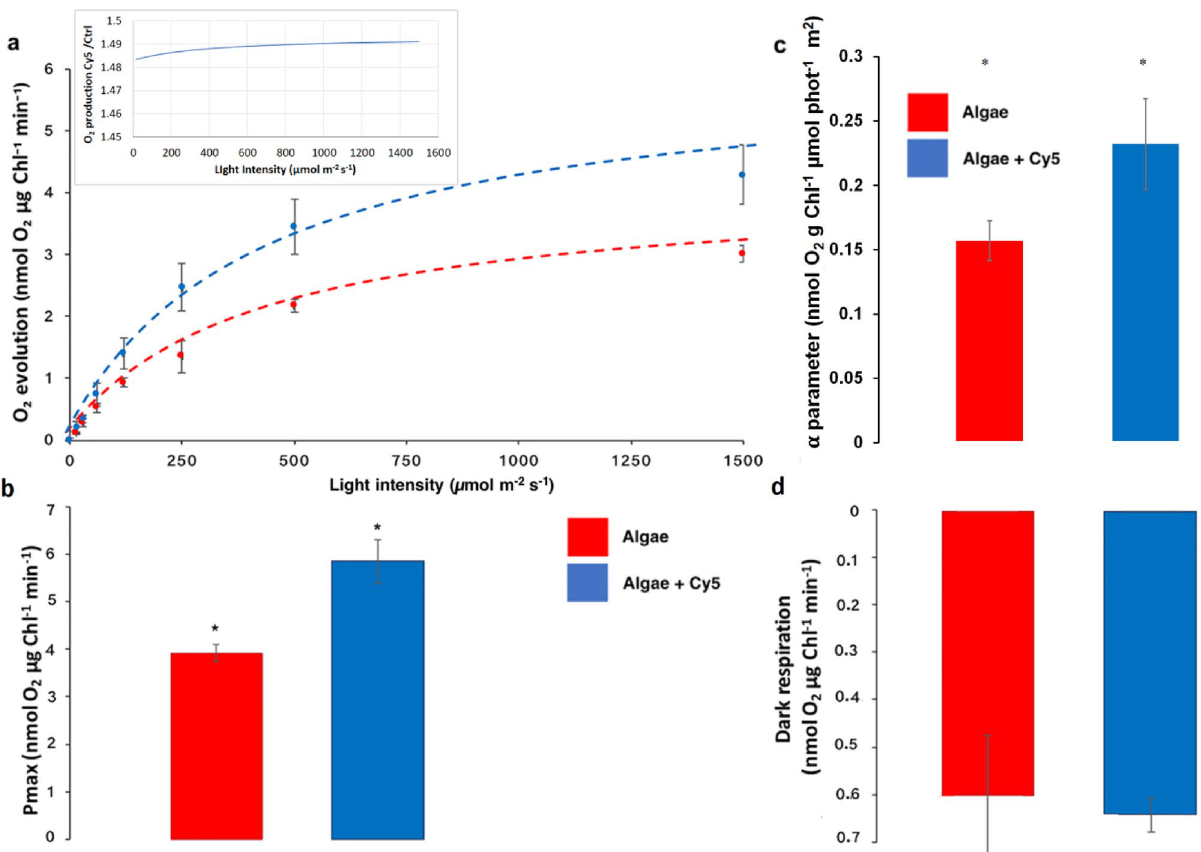
Figure 4. Light response curves. ( a ) Algae oxygen evolution rates at different actinic lights in the presence (blue line) and absence (red line) of Cy5. ( b ) Pmax: Experimental data were fitted with hyperbolic function y = Pmax * x/(KI + x); ( c ) α-parameter related to the photosynthetic efficiency at limiting light intensity; ( d ) Oxygen consumption by dark